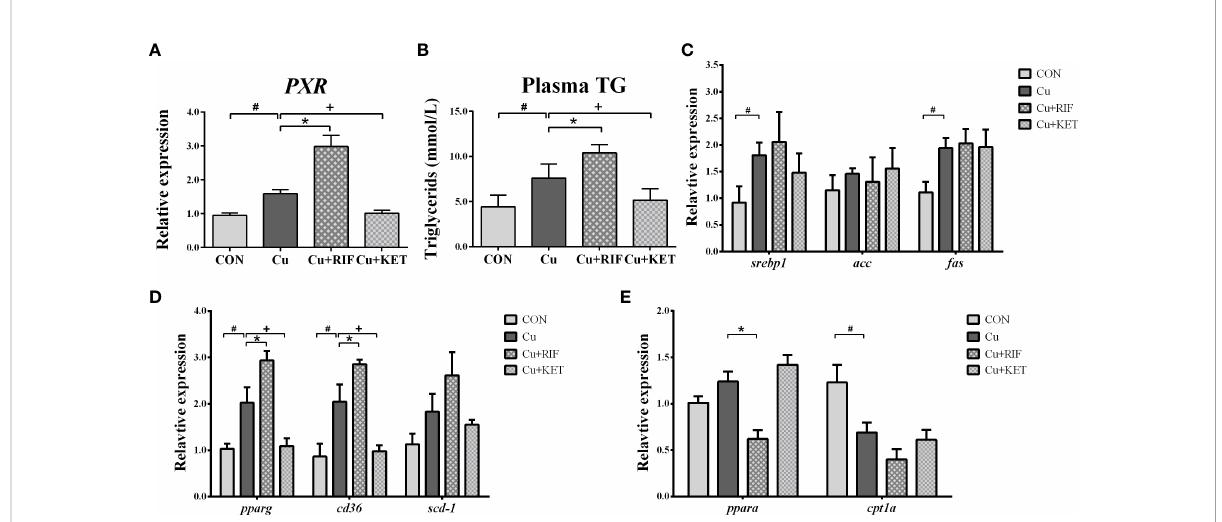
FIGURE 3 PXR responses and lipid metabolism related index in the liver of largemouth bass subjected to RIF or KET under Cu exposure (n = 6). (A) mRNA levels of PXR in the liver; (B) plasma triglycerides (TG); (C) hepatic mRNA levels of srebp1 , acc and fas ; (D) hepatic mRNA levels of ppar g , cd36 and scd - 1 ; (E) hepatic mRNA levels of ppar a and cpt1a . Signi fi cant differences between CON and Cu groups, Cu and Cu+RIF groups, as well as Cu and Cu+KET groups were indicated by “ # ” , “ * ” , and “ + ” ( P < 0.05).